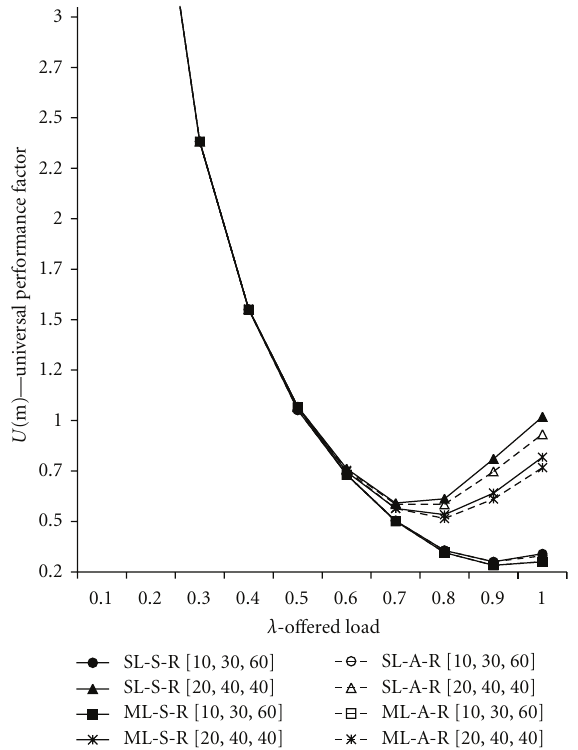
Figure 11: Universal performance factor of low-priority packets versus o ff ered